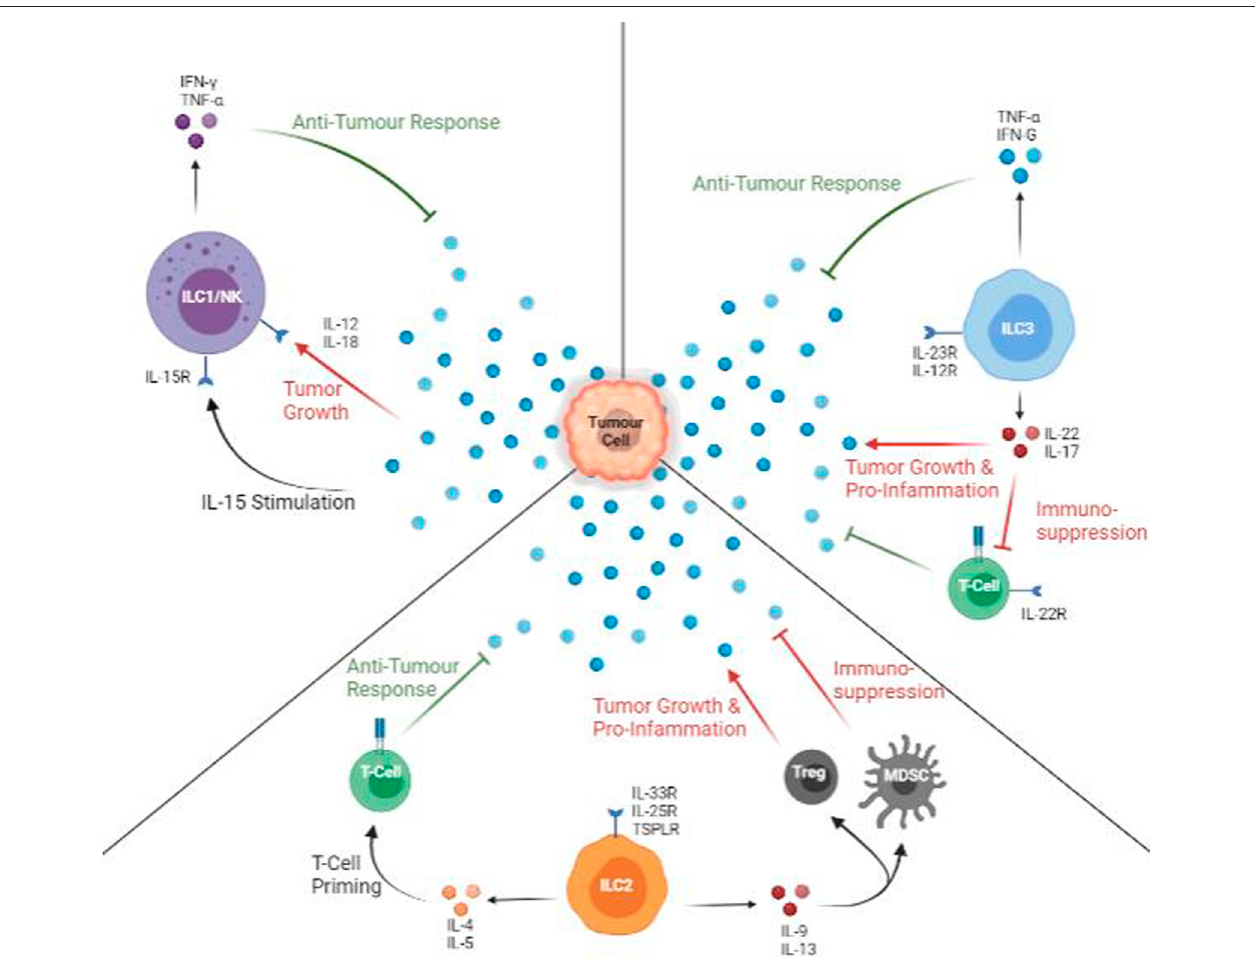
FIGURE 2 | Anti-tumour and Pro-tumour Roles of ILCs. All types of ILCs can protect against (green arrows) and promote (red arrows) tumour growth. ILC1s are active via IL-15, and IFN- γ and TNF- α are released. In the presence of IL-12 or IL-18, ILC1 cytokine pro fi le is decreased,facilitating tumour growth. ILC2s are stimulated mainlybyIL-33,but itproducesamixofpro-and anti-tumourcytokines. IL-5canaidinT-cellprimingwithtumourspeci fi cmarkers whileIL-9 orIL-13promoteTregand myeloid-derived suppressor cells,promotingin fl ammation andsuppressingT-cells.ThepresenceofIL-12promotesanti-tumourcytokines. ThepresenceofIL-23 promotes productions pro-tumour and suppressive